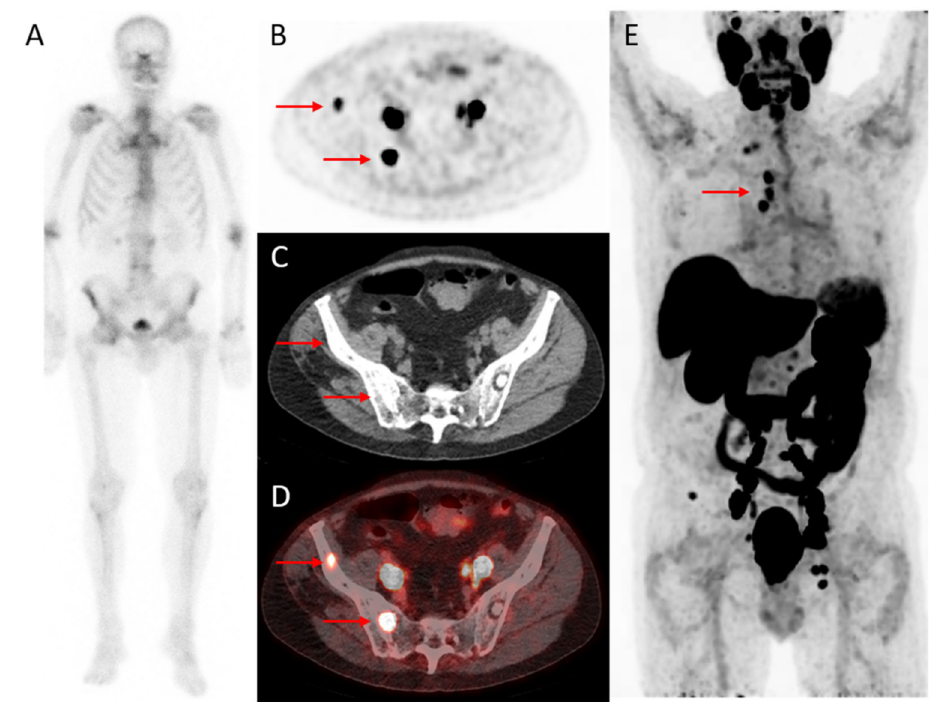
Figure 2. A 79-year-old patient with CRPC after initial treatment with radiotherapy followed by hor- monal therapy. Images illustrate improved detection of bone metastases using 18 F-DCFPyL PET/CT compared to bone scintigraphy (4 weeks interval). The PSA level at PET was 23 ng/mL. On bone scintigraphy, faint uptake in the lumbar spine, the right acromioclavicular joint, the sternoclavicular, and hip joints were attributed to degenerative changes ( A ). Transversal 18 F-DCFPyL PET ( B ) and fused PET/CT ( D ) revealed two foci (red arrows) with intense PSMA-expression in the right iliac bone (SUV max : cranial lesion 6.2 and caudal lesion 17) and a sclerotic substrate on CT ( C ) and were classified as highly suspicious for bone metastases. Maximum intensity projection ( E ) demonstrated additional lymph node metastases above the